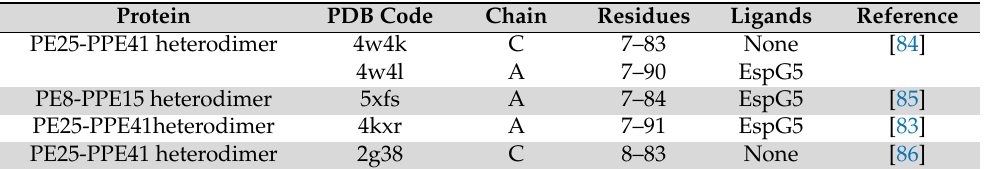
Table 2. Structures of PE-like domains in Mycobacterium tuberculosis ( Mtb ).